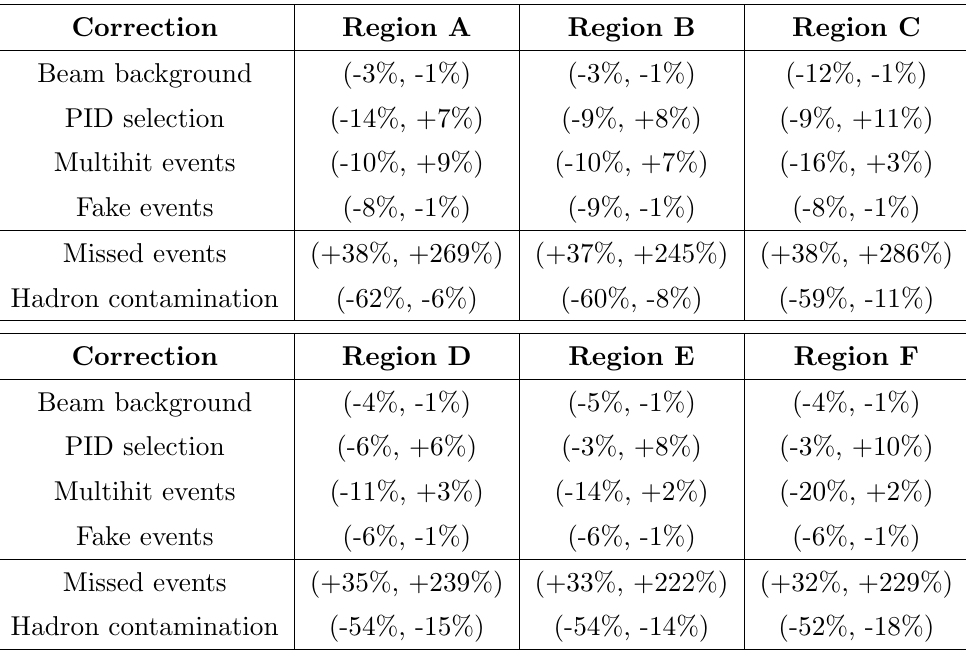
Table 2 . The (minimum, maximum) values of the relative correction factors for each contribution discussed here, separately reported for regions A, B, C, D, E and F. The top four and the bottom two corrections are respectively applied before and after